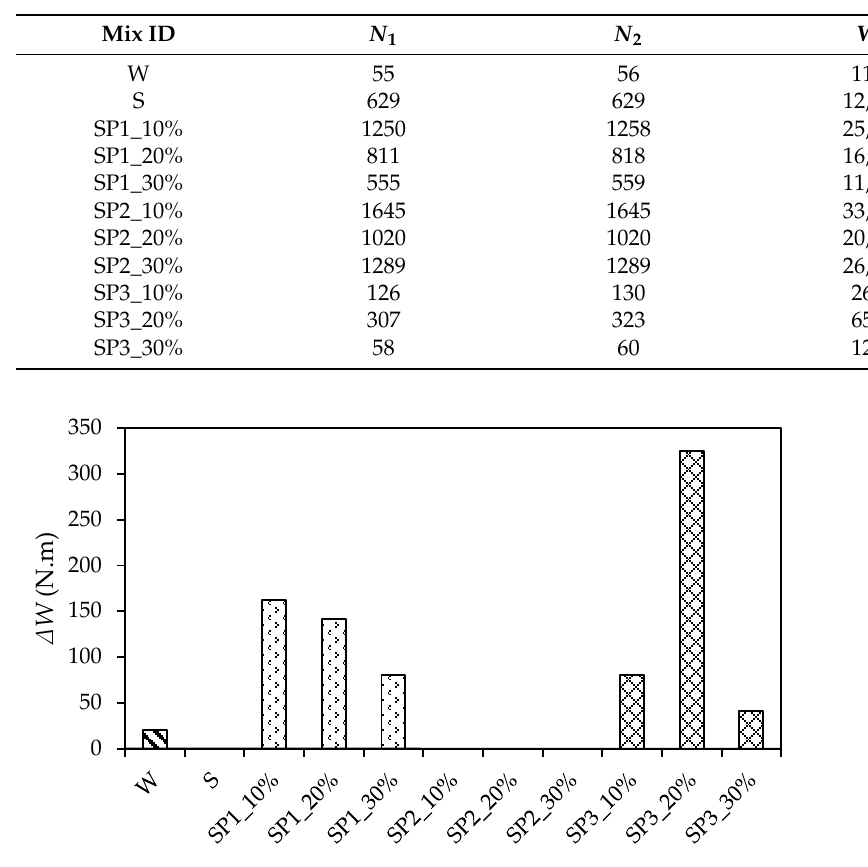
Figure 11. Comparison of ΔW.